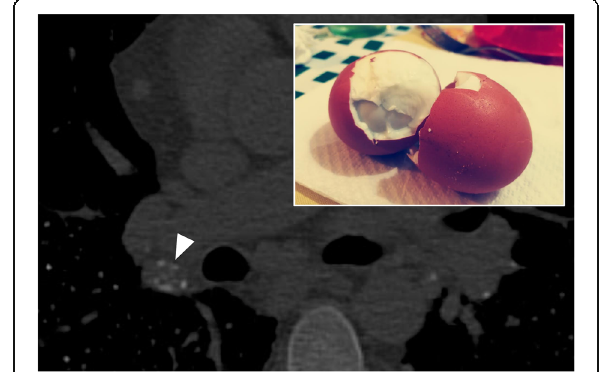
Fig. 10 Eggshell calcifications. A small peripheral lamellar calcification (white arrowhead) of an enlarged lymphatic node, in a patient with silicosis; however, these calcifications, which reproduce the appearance of eggshells, are a non-specific sign of silicosis, since they may be encountered in various diseases, such as advanced sarcoidosis, pneumoconiosis, scleroderma, amyloidosis, lymphoma after radiotherapy, blastomycosis, and